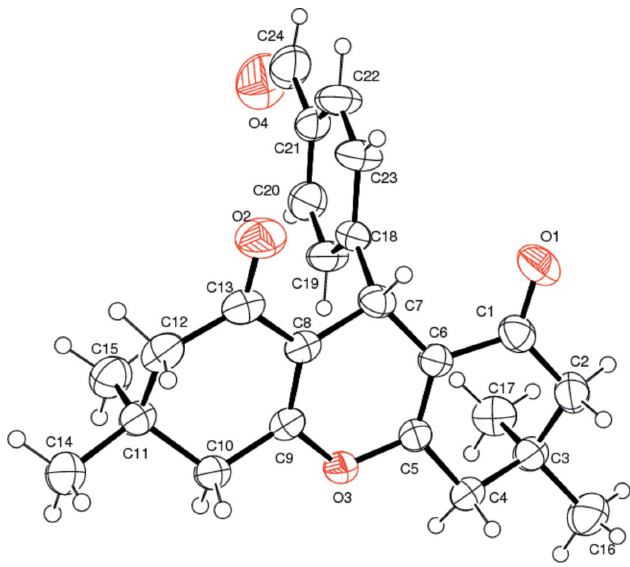
Figure 1 The molecular structure of the title compound, showing the atom- numbering scheme. Displacement ellipsoids are drawn at the 40% probability